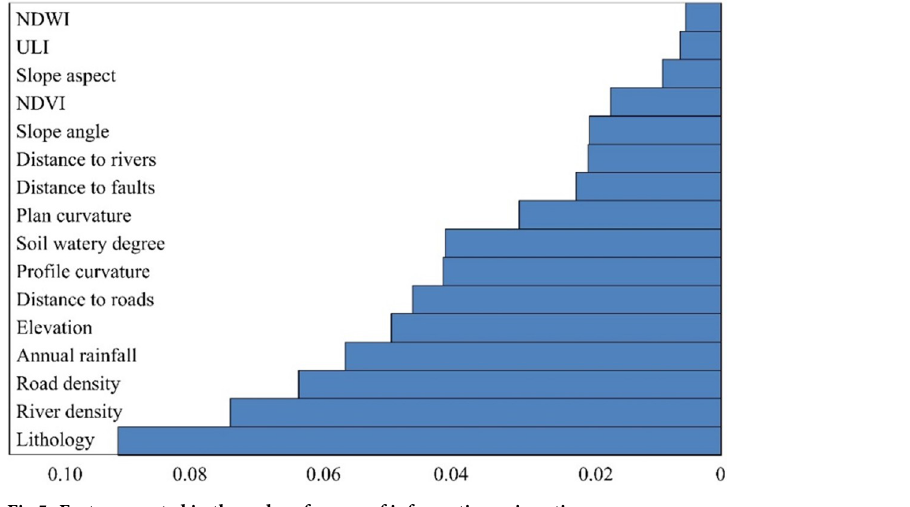
Fig 5. Features sorted in the order of scores of information gain